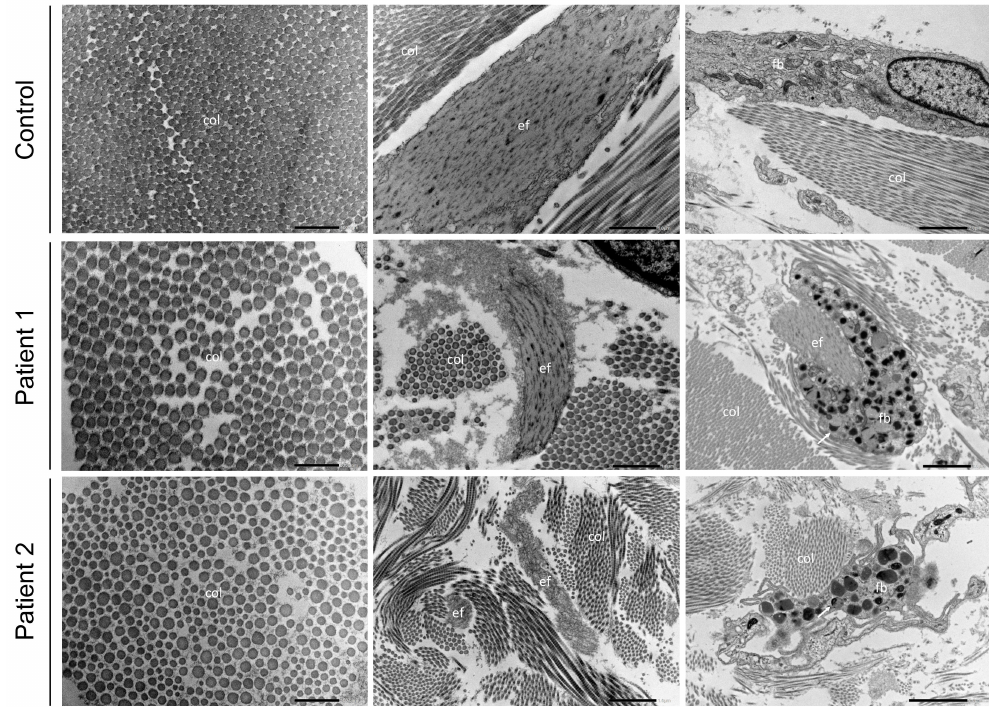
Figure 4. Transmission electron microscopy findings in occipital horn syndrome. Transmission electron microscopy (TEM) findings in skin samples of patients F1:II-1 and F2:II-1 and a matched control showing collagen (column 1), elastic fibers (column 2) and a fibroblast (column 3). col = collagen; ef = elastic fiber; fb = fibroblast. Magnification for column 1: × 15,000, column 2: × 8000 and column 3: ×